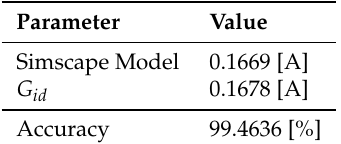
Table 3. Statistic mean of the inductor current.